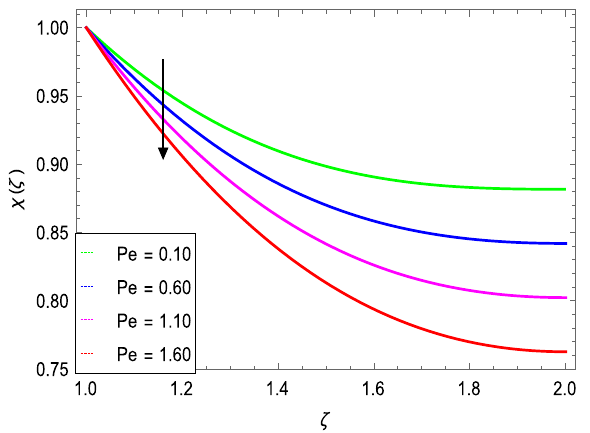
Figure 17. χ (ζ) as a function of Pe .